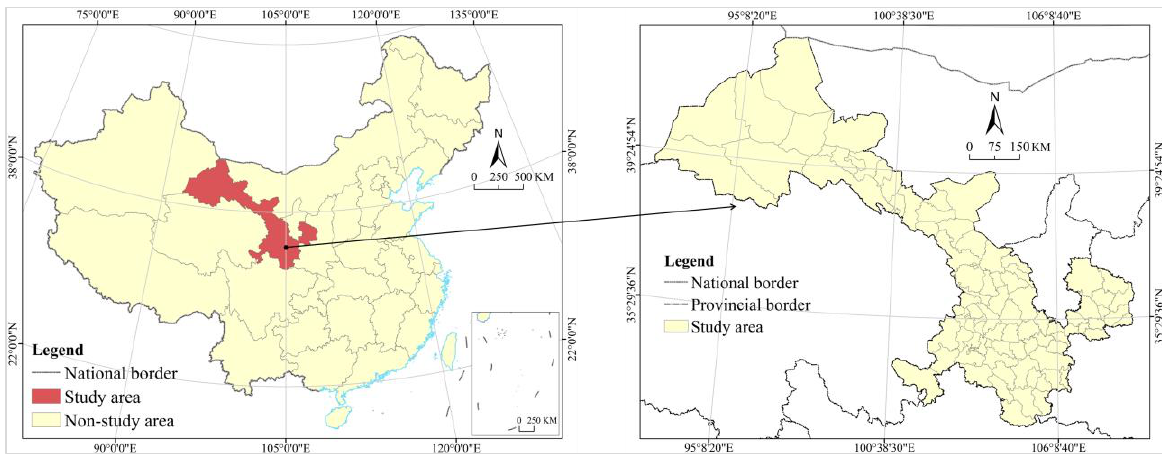
Figure 1. Study area.